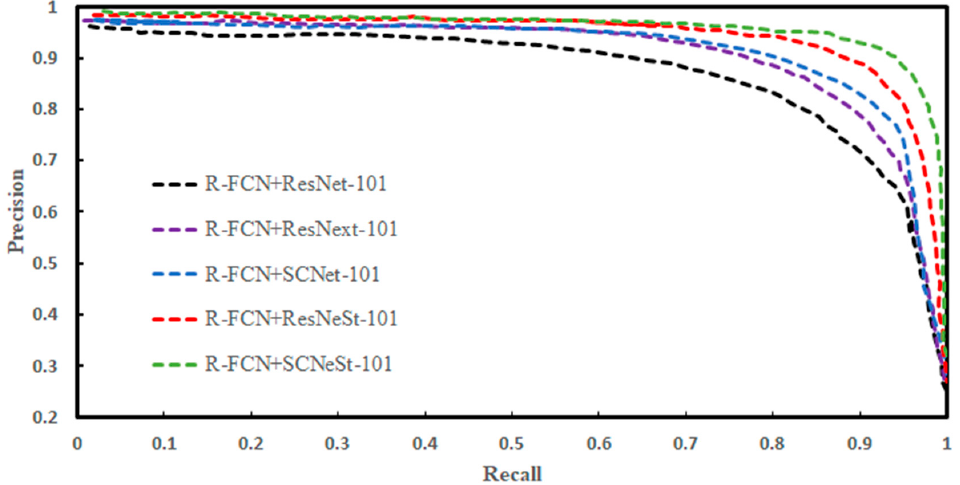
Figure 11. The P-R curves for different models